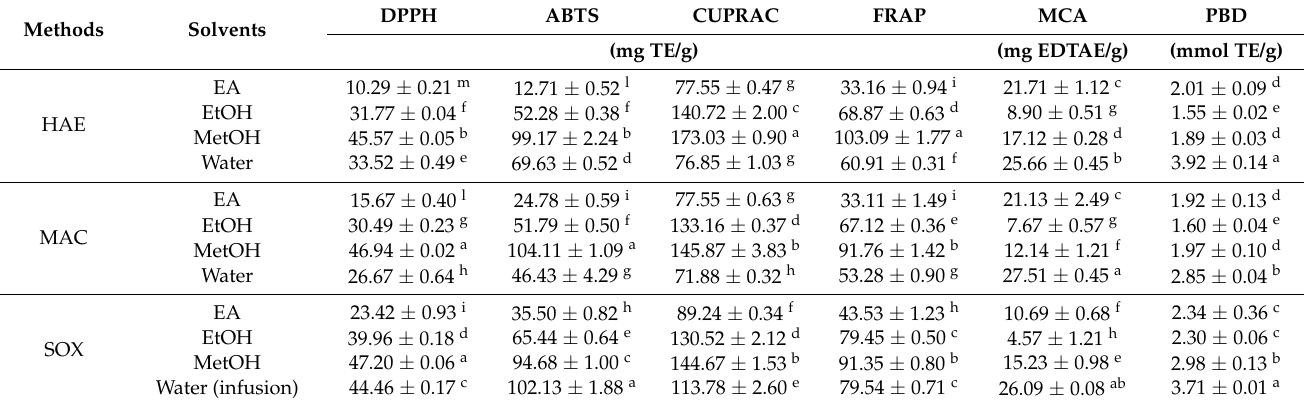
Table 1. Antioxidant properties of the tested